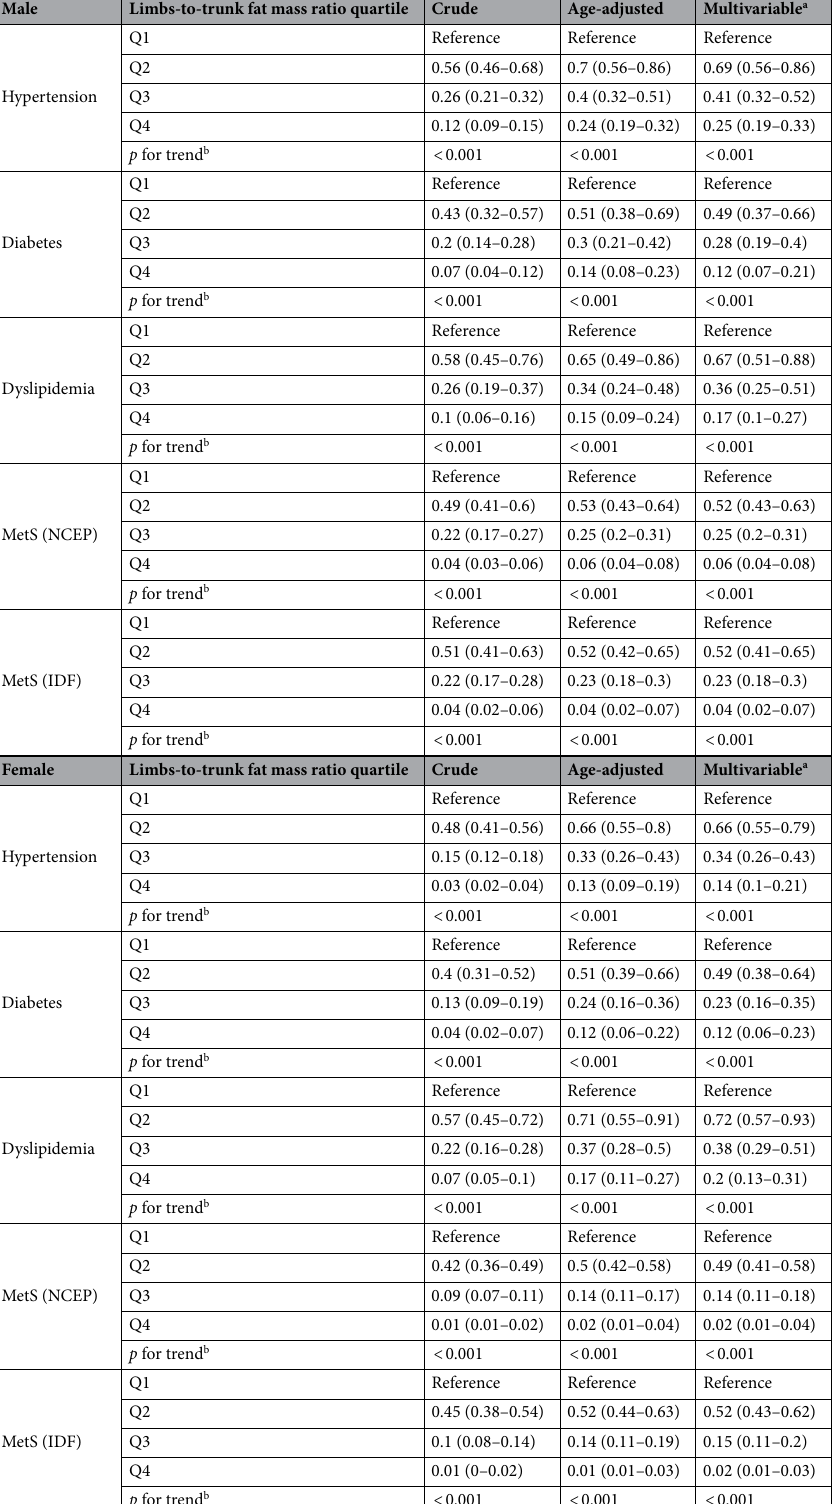
Table 4. Odds ratios for cardiovascular disease risk factors according to limbs-to-trunk fat mass ratio quartile. Data are presented as odds ratio (95% confidence interval). MetS, metabolic syndrome; NCEP, 2005 National Cholesterol Education Program Adult Treatment Panel III; IDF, 2006 International Diabetes Federation. a Multivariable model adjusted for age, energy intake, water intake per body weight, smoking, alcohol drinking, physical activity, education, income, and survey year. b Test for linear trend across quartile of limbs-to-trunk fat mass